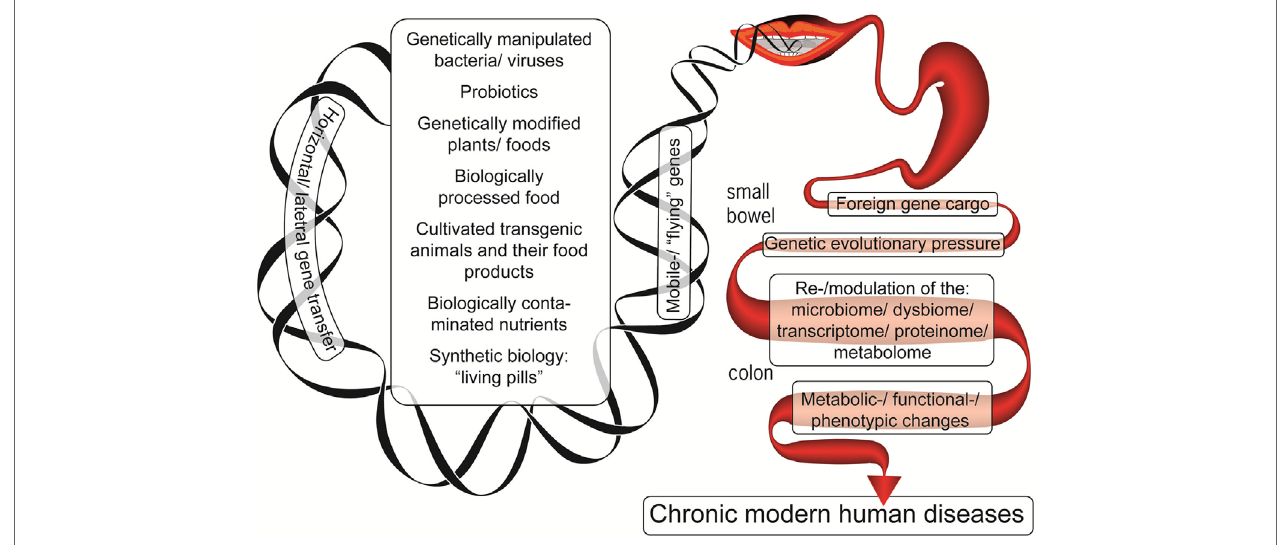
FiGUre 1 | The foreign genetic cargo that environmental factors can deliver by horizontal gene transfer to the enteric microbiome, resulting in chronic human